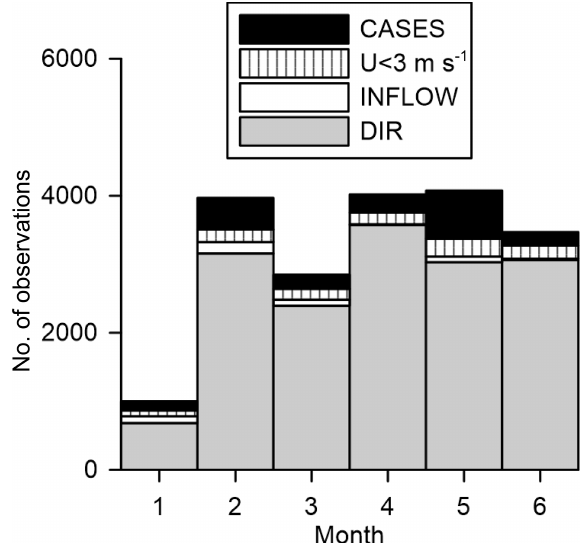
Figure 11. Results of the wake case selection pre-processing (flow chart shown in Fig. 4) by calendar month (1 is January 2017, 2 is February 2017 and so on). The total column heights indicate the number of 10min periods for which data are available in each month. DIR indicates the number of scans excluded from consider- ation because the VAD-derived wind direction was not 210 or 240 ◦ . INFLOW indicates the number of scans filtered out by having in- sufficient observations at or slightly beyond the wind turbine to de- termine the inflow. U <3ms − 1 indicates scans filtered by having wind speed at hub height lower than the wind turbine cut-in wind speed at the turbine location. CASES denotes the 10min periods that are identified as potential wake cases that meet the criteria for quantitative